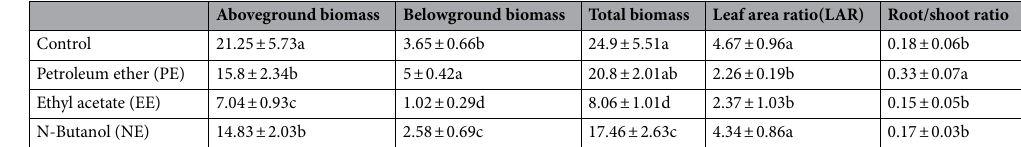
Table 1. Effects of three chemical extracts on the biomass, LAR and Root/shoot ratio of A.philoxeroides (Mean ± SD) . The treatments with the same letter are not significantly different at the 0.05 level.